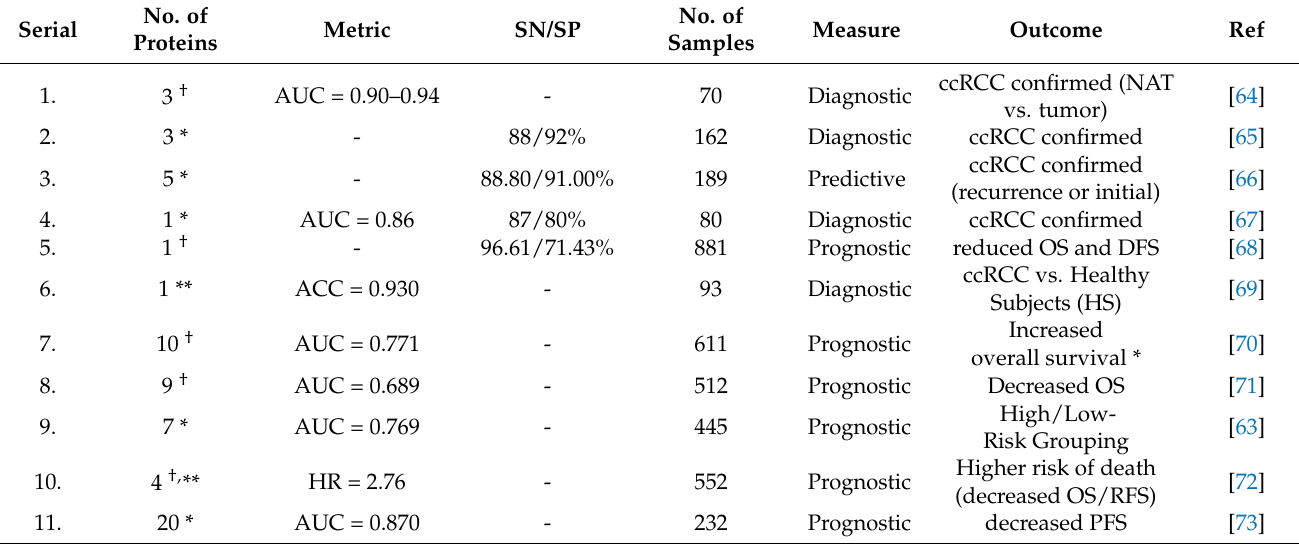
Table 4. Studies identifying proteomic signature for clinical management and treatment of renal cell carcinoma